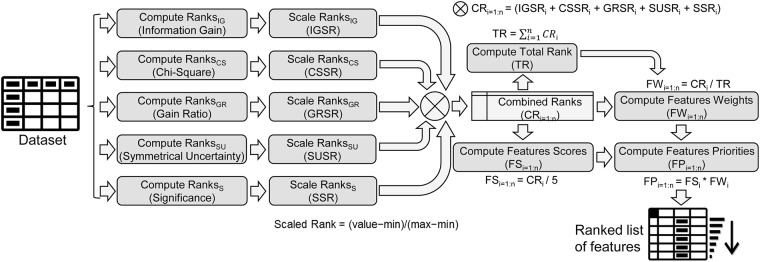
UFS algorithm [19].